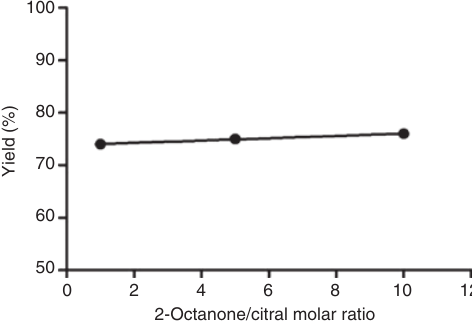
Figure 1: Effect of 2-octanone/citral molar ratio on yield of 11,15-dimethyl-hexadeca-8,10,14-trien-7-one. (Catalyst amount of 5%, 60 ° C, 3.5 h).